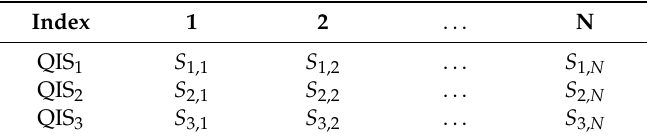
Table 1. Quantized index sequence.